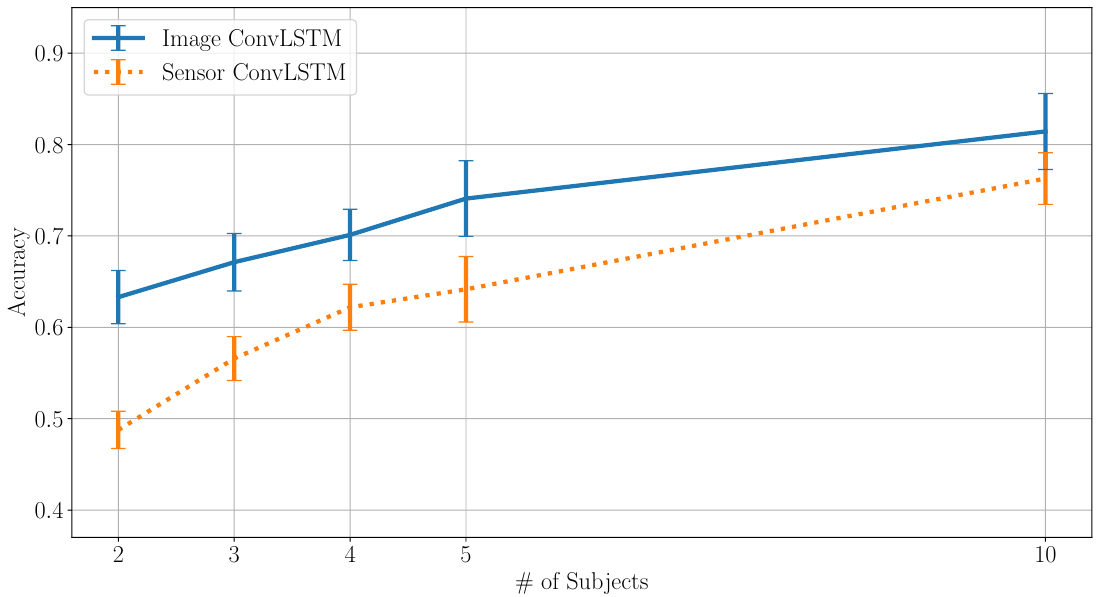
Figure 6. Model performance on DIP-IMU data for a varying number of subjects on 1 IMU signal